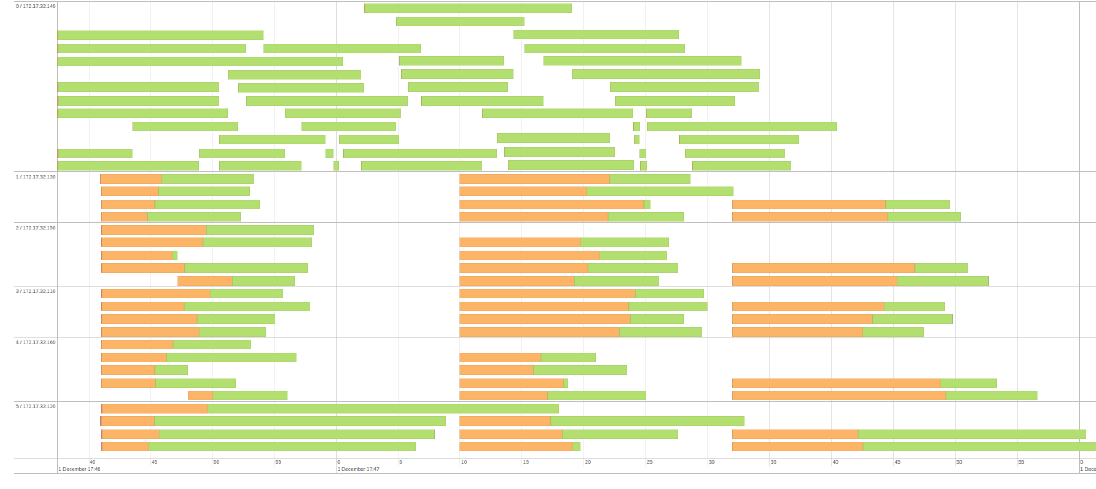
Figure 9. The workload without the repartitioning after the similarities filter.